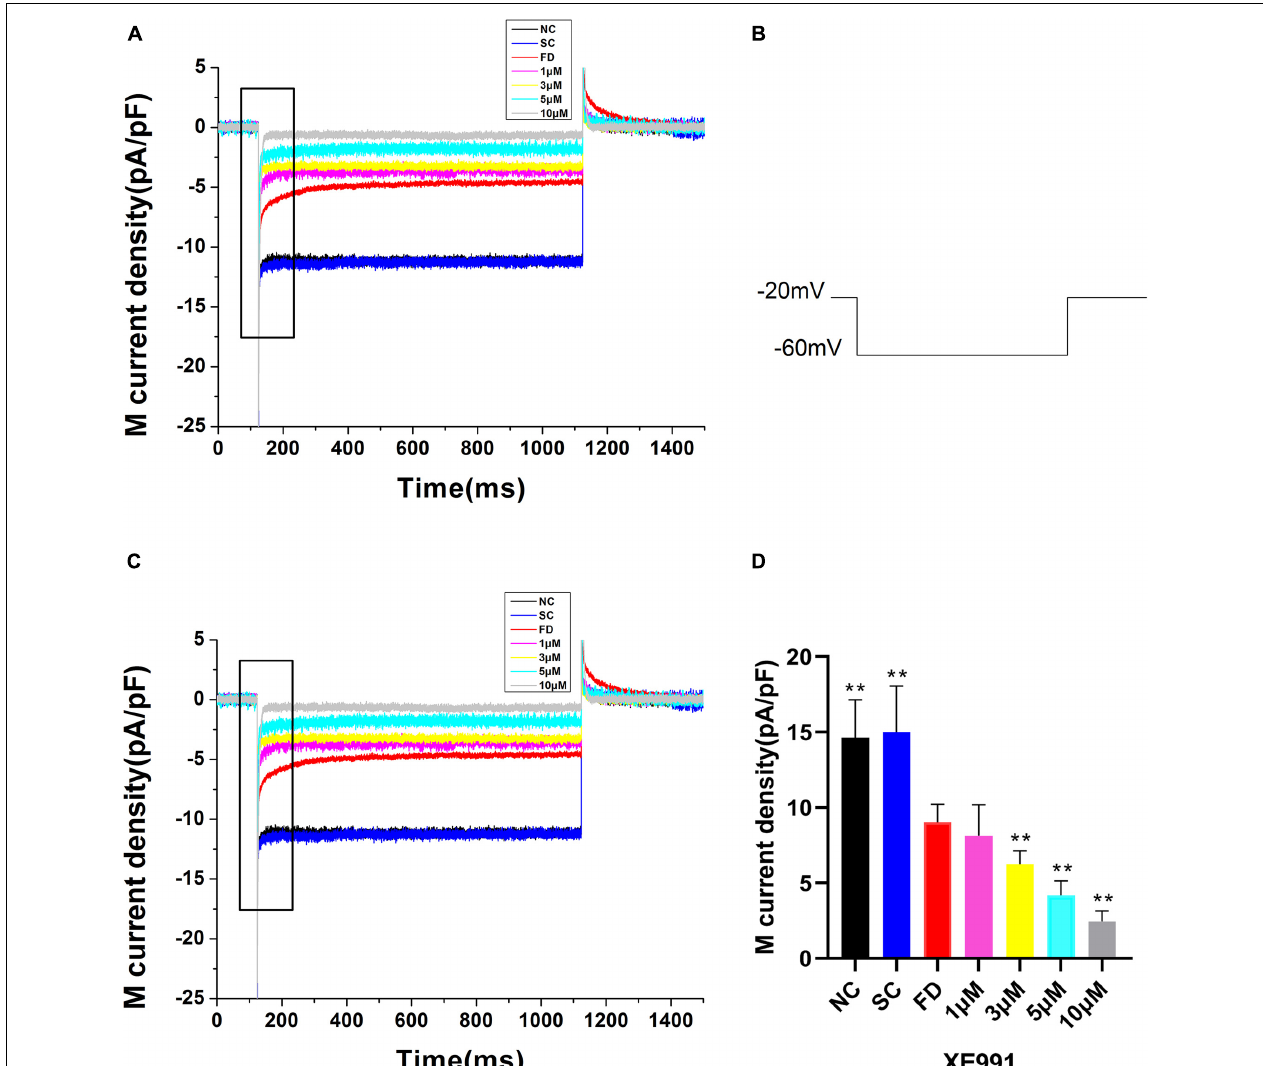
FIGURE 8 | M-currents treated with XE991 in the FD group. (A) I K ( M ) density of RPE cells treated with different concentrations of XE991. (a) Black, before administration; (b) Red, 1 µ M; (c) Blue, 3 µ M; (d) Purple, 5 µ M; (e) Gray, 10 µ M. (B) Protocol for recording M-current. (C) The expanded recordings from the dashed box in (A) , indicated the effect of XE991 on the I K ( M ) density. (D) Statistical graph of the M-current density of each group. When the concentration increased over 3 µ M, the differences were statistically significant (** P <